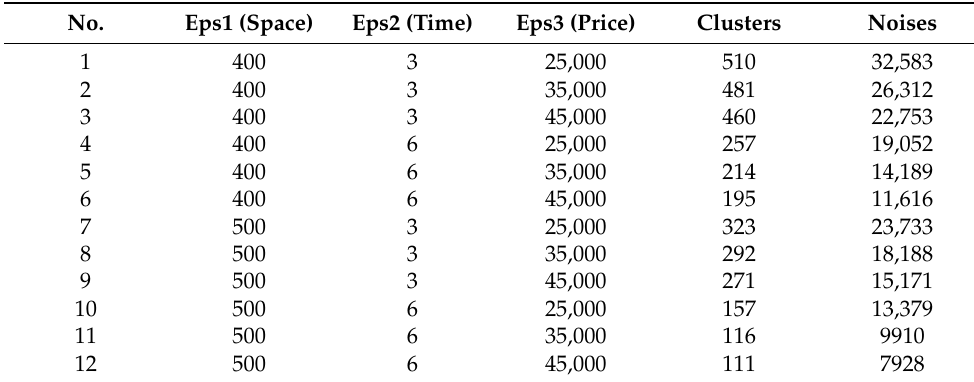
Table 2. Changes in clusters according to parameter